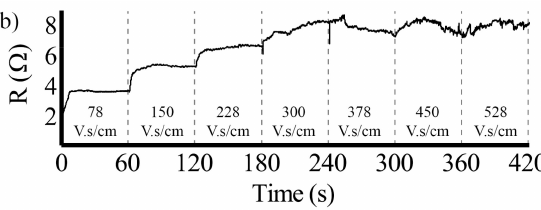
Figure 5. ( a ) Electropherograms, of the sample mixture separation at increasing separation power, recorded at 25 mm from the sample inlet. ( b ) Electrical resistance variation with separation power during the separation process.